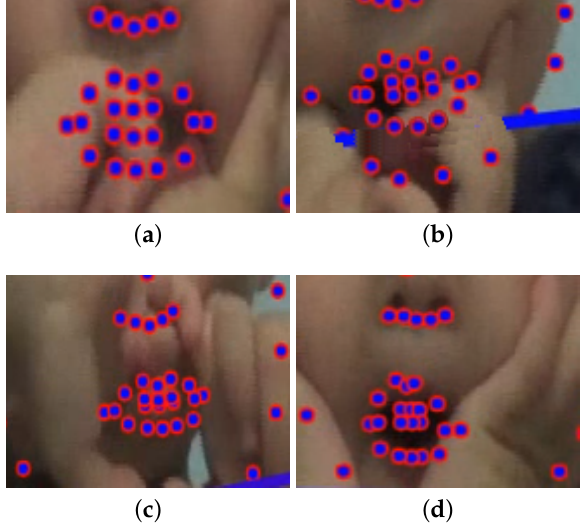
Figure 6. Some situations that generated miss matches between the outcomes of the system and the annotations of experts: ( a ) the child affected the positioning of landmarks for both upper and lower face parts while performing a happy expression; ( b ) the child affected the positioning of landmarks for both upper and lower face parts while performing a sad expression; ( c ) the child affected the positioning of landmarks for only the lower part of the face while performing an anger expression; ( d ) the child affected the positioning of landmarks for only the lower part of the face while performing a fear